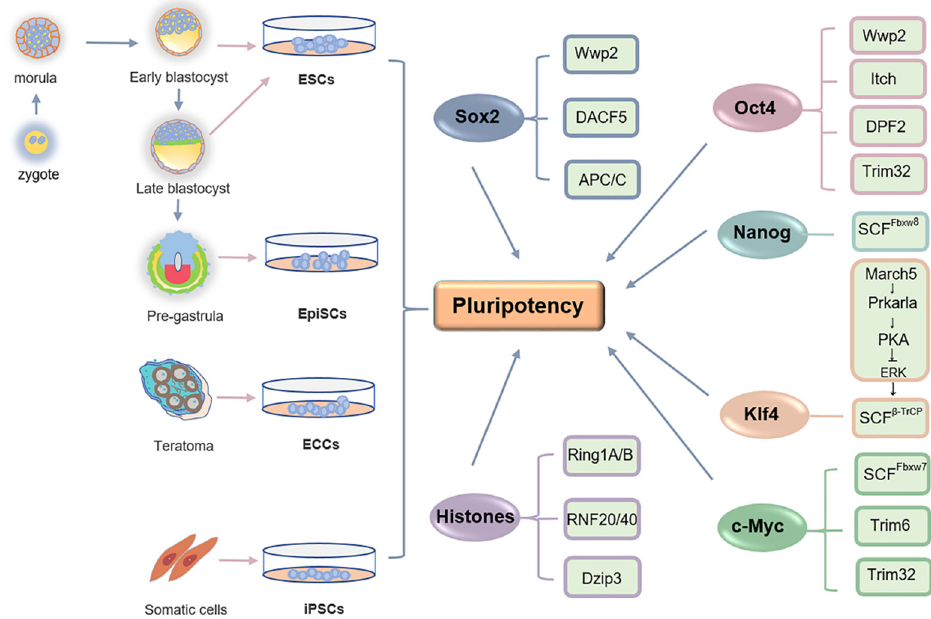
Figure 1. E3s are involved in regulating pluripotency. Pluripotent cells can be derived from teratomas or early embryos. Pluripotency can also be restored through introducing defined factors in somatic cells to generate iPSCs. Multiple E3s have been identified for their critical roles in monitoring the stability or activity of pluripotency regulators.